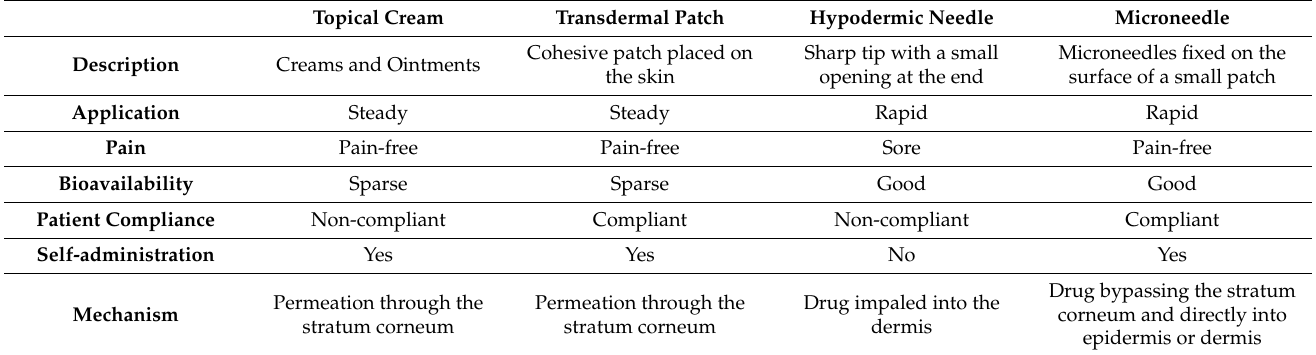
Table 1. Comparative analysis and drug delivery applications of transdermal patches, hypodermic needles, and topical creams. Adapted from